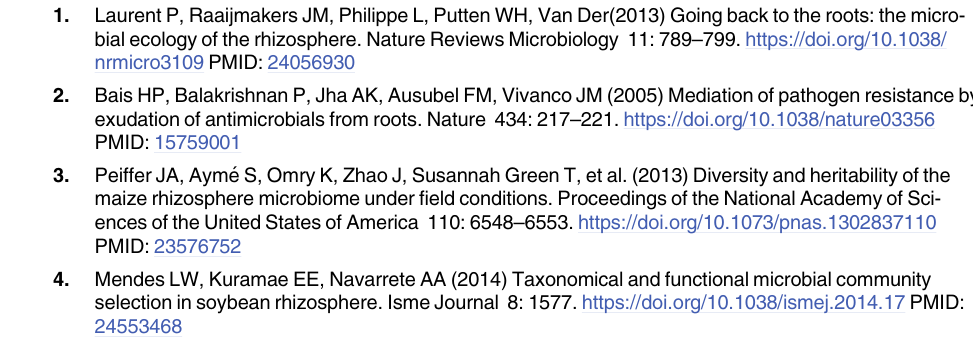
S1 Fig. Plate crossing experiments confirm the compatibility of three Bacillus strains. KC, DY, and JDF indicate B . subtilis , B . licheniformis , and B . amyloliquefacien s treatments, respec- tively. S2 Fig. Principal component analysis (PCA) of the community structure of different sam- ples at the genus level. CK, KC, DY, JDF, and FH groups indicate control, B . subtilis , B . liche- niformis , B . amyloliquefacien s, and combined strains treatments,